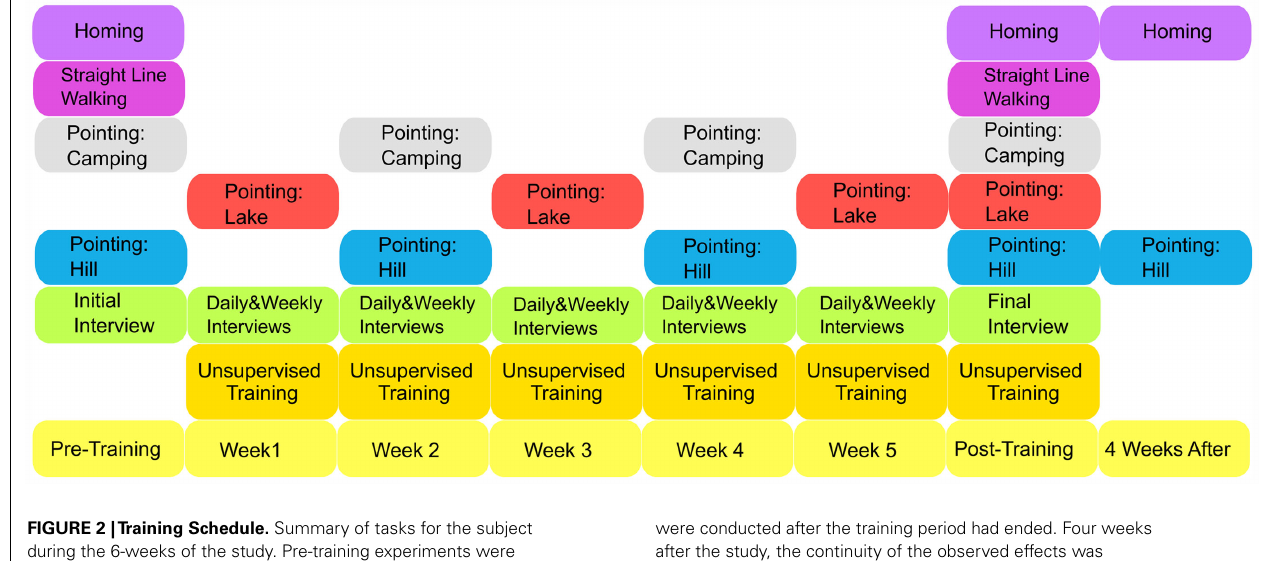
were conducted after the training period had ended. Four weeks after the study, the continuity of the observed effects was